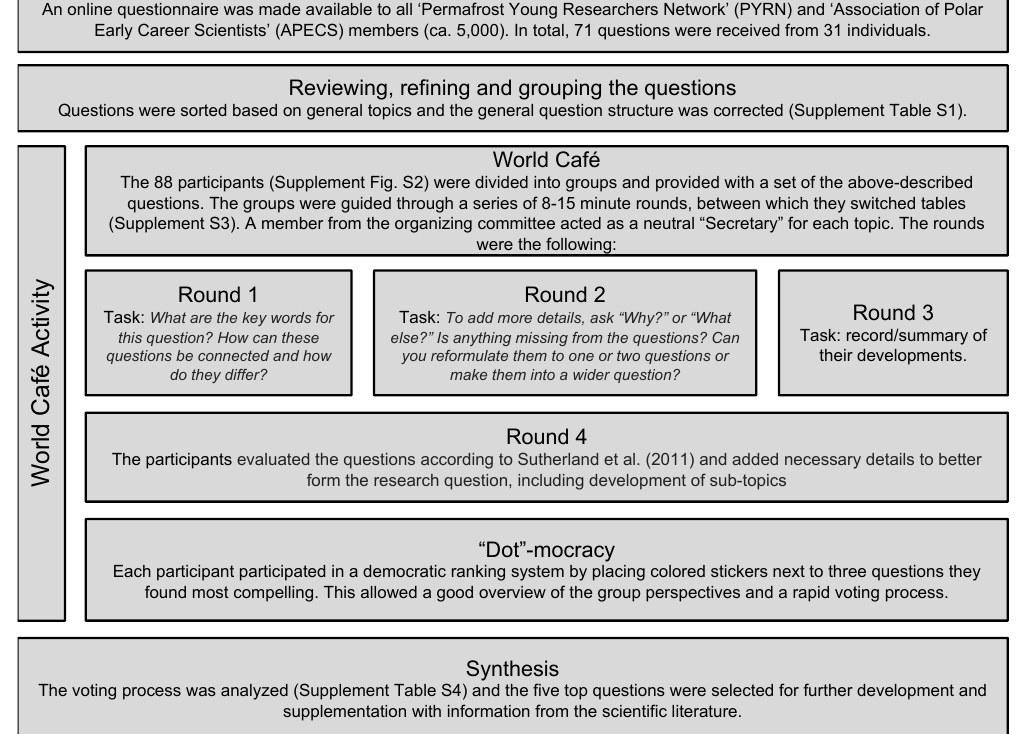
Round 3 Task: record/summary of their developments.